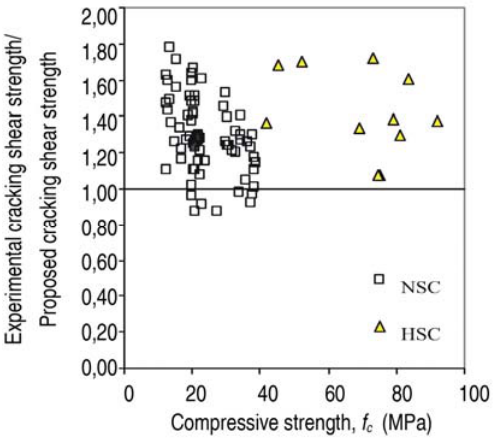
Fig. 5. Comparing proposed cracking shear strength of Eq (15) with ACI Code for various compressive strength values